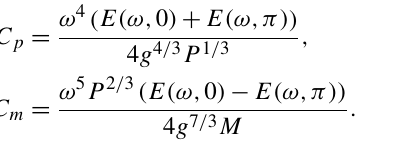
Figure 9. Left – estimates of the first Kolmogorov constant C p ; right – estimates of the second Kolmogorov constant C m for the approximate anisotropic KZ solution (Eq. 6). (a, b) run sw030; (c, d) sw230; (e, f) sw330. Time in hours is given in the